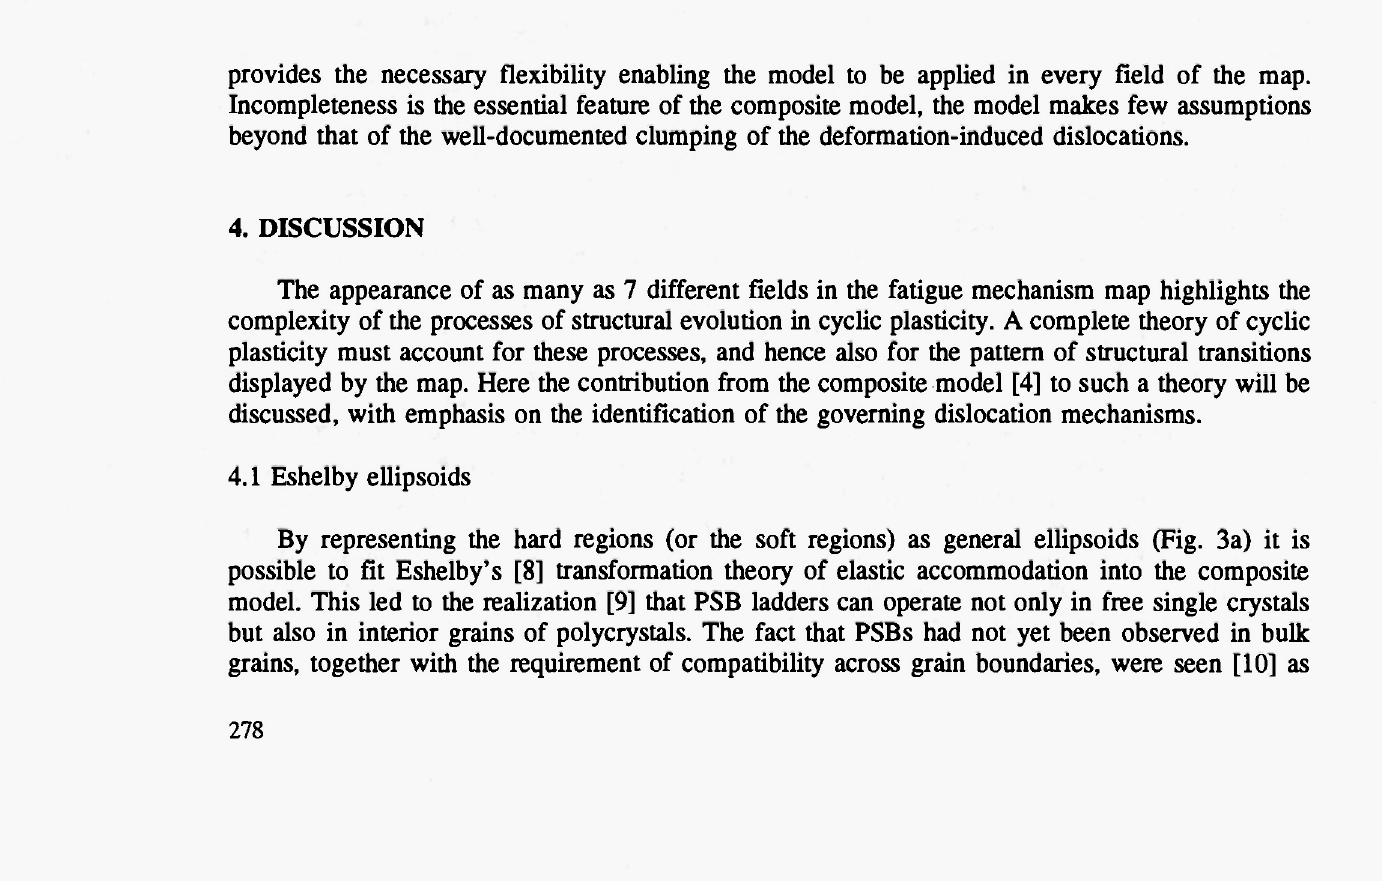
Fig. 3. The composite model, reproduced from [4], is sufficiently flexible to deal with every field in the fatigue mechanism